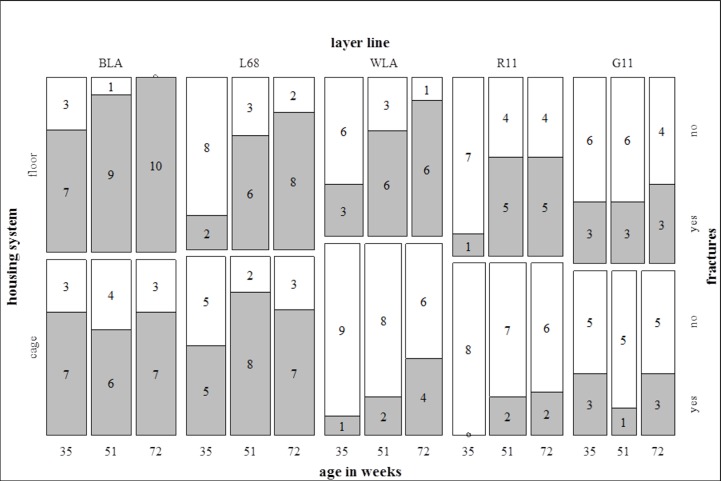
Fracture prevalence.Each bar represents the total amount of radiographed and evaluated hens of one layer line within one housing system. The grey part of a bar shows the part of hens with a fractured keel bone, the white part those without any fracture. The numbers written in the bars show the total numbers of affected or non-affected hens, respectively. Fracture prevalence was affected by layer line (p<0.05 at all three ages) and age (p<0.001). Housing system significantly influenced fracture prevalence in the 72nd week of age (p<0.05).